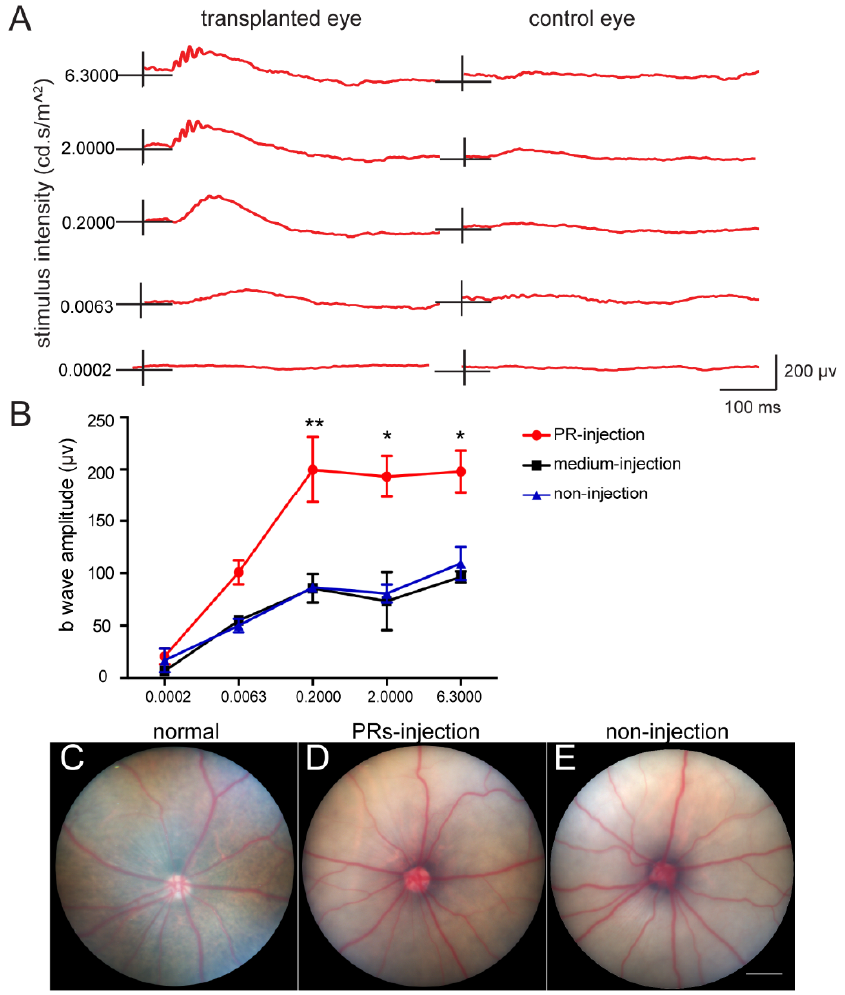
Figure 4. Subretinal transplantation of hAESCs–PR–like cells showed partially functional rescue in RCS rats. ( A ) Representative ERG responses in a transplantation eye and its fellow control eye. ( B ) Mean b–wave amplitudes at different intensity showing a similar preservation pattern compared to groups of control eyes, n = 4 per group. ( C – E ) Representative color fundus images of normal rat eye, hAESCs–PR–like injection eye of RCS rat, and non–injection eye of RCS rat. 2 mm in ( C – E ). Error bars represent mean ± SEM. * p < 0.05, ** p < 0.01; two–way ANOVA followed by Tukey’s multiple comparisons test.